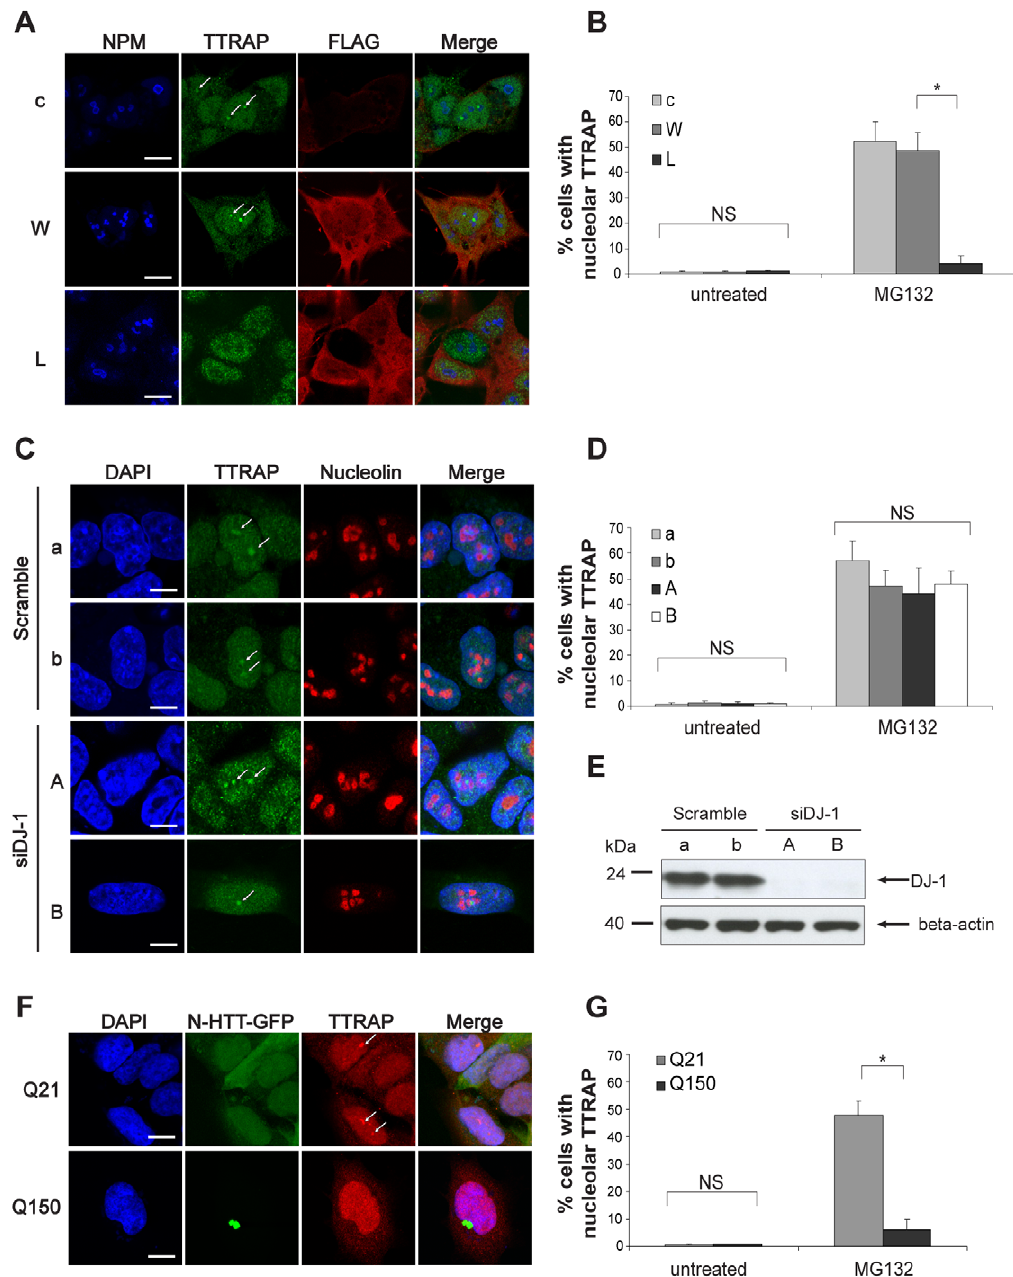
Figure 2. Mutant DJ-1 L166P inhibits TTRAP nucleolar localization after proteasome inhibition. (A) TTRAP nucleolar localization is inhibited in L166P expressing cells. SH-SY5Y cells stably transfected with empty vector (c), FLAG-DJ-1 wt (W) or L166P (L) were treated with 5 m M MG132 for 16 h. Triple immunofluorescence was performed with anti-NPM (blue), anti-TTRAP (green) and anti-FLAG (red) antibodies. Images are representatives of three independent experiments. Data have been confirmed on two independent clones for each cell line. Bars, 10 m m. (B) Quantification of TTRAP nucleolarlocalization. Cells as inA. At least200cells from twoindependentexperimentswere counted andscoredforTTRAP in the nucleolus (*, p , 0.05). (C) Localization of TTRAP is unaffected in cells depleted of endogenous DJ-1. SH-SY5Y cells stably expressing an inducible short-hairpin RNA targeting DJ-1 (siDJ-1, clones A andB) or a scramble shRNA control (scramble, clones a and b) were treated with doxycycline for 10 days to induce silencing of DJ-1 expression. Then cells were treated with 5 m M MG132 for 16 h. Immunofluorescence was performed with anti-TTRAP (green) and anti-NCL (red) antibodies. Nuclei were visualized with DAPI (blue). Images are representatives of two independent experiments. Bars, 10 m m. (D) Quantification of TTRAP nucleolar localization in siDJ-1 cells. Data were collected as in B. (NS, not-significant). (E) DJ-1 is efficiently depleted in siDJ-1 cells. Total protein lysates were prepared from cells as in C. Levels of endogenous DJ-1 were measured by western blot with anti-DJ-1 antibody. Beta-actin was detected as loading control. (F) TTRAP nucleolar localization is altered by mutant huntingtin. SH-SY5Y cells were transfected with huntingtin N-terminal fragment fused to GFP with WT (Gln 21 , Q21) or mutated (Gln 150 , Q150) polyglutamine expansion. Endogenous TTRAP was visualized by indirect immunofluorescence (red). N-HTT was visible by GFP autofluorescence. Nuclei were visualized with DAPI (blue). Bars, 10 m m. (F) Quantification of TTRAP nucleolar localization in N-HTT expressing cells. Data were collected as in B on GFP-positive cells (*, p , 0.05; NS, not-significant).